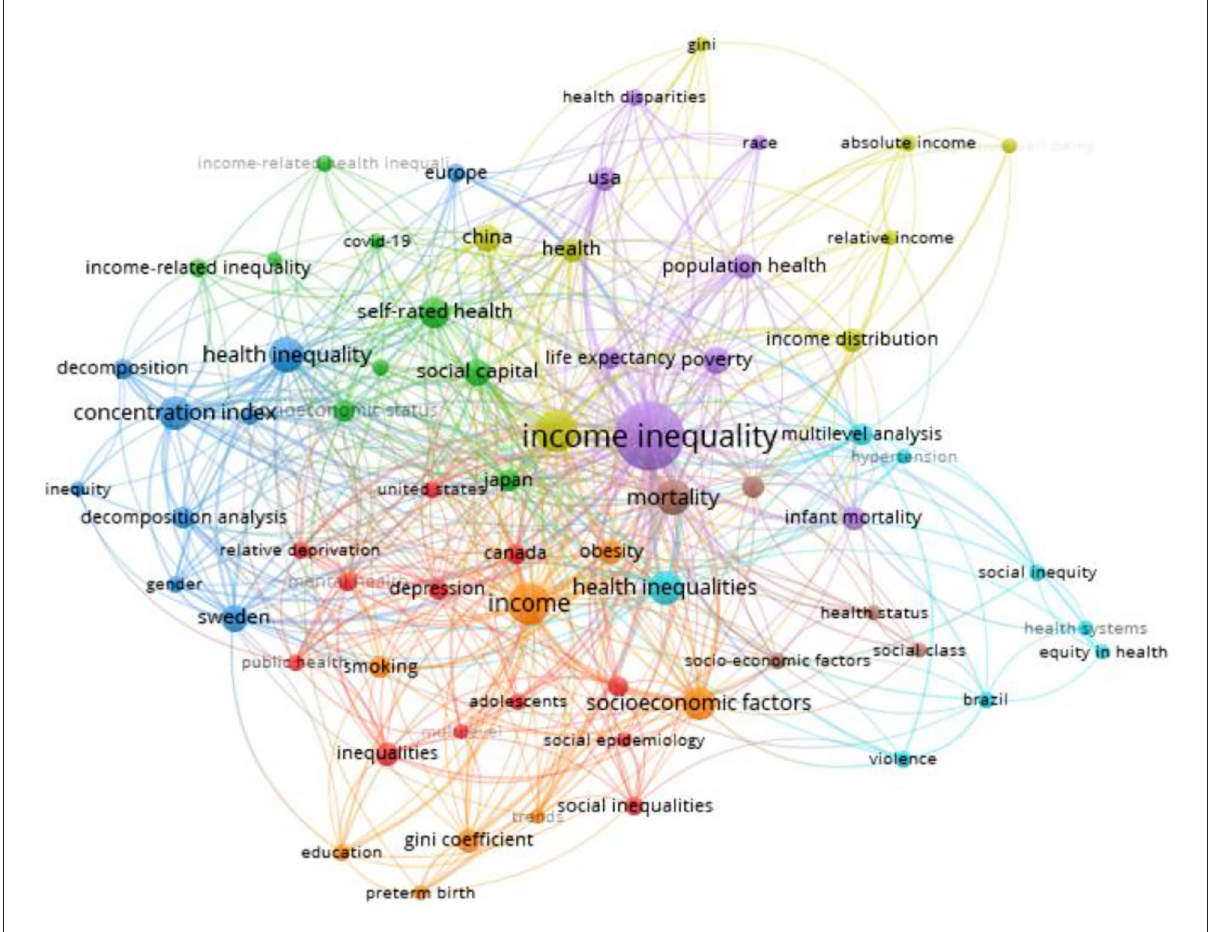
FIGURE7 Keyword co-occurrence